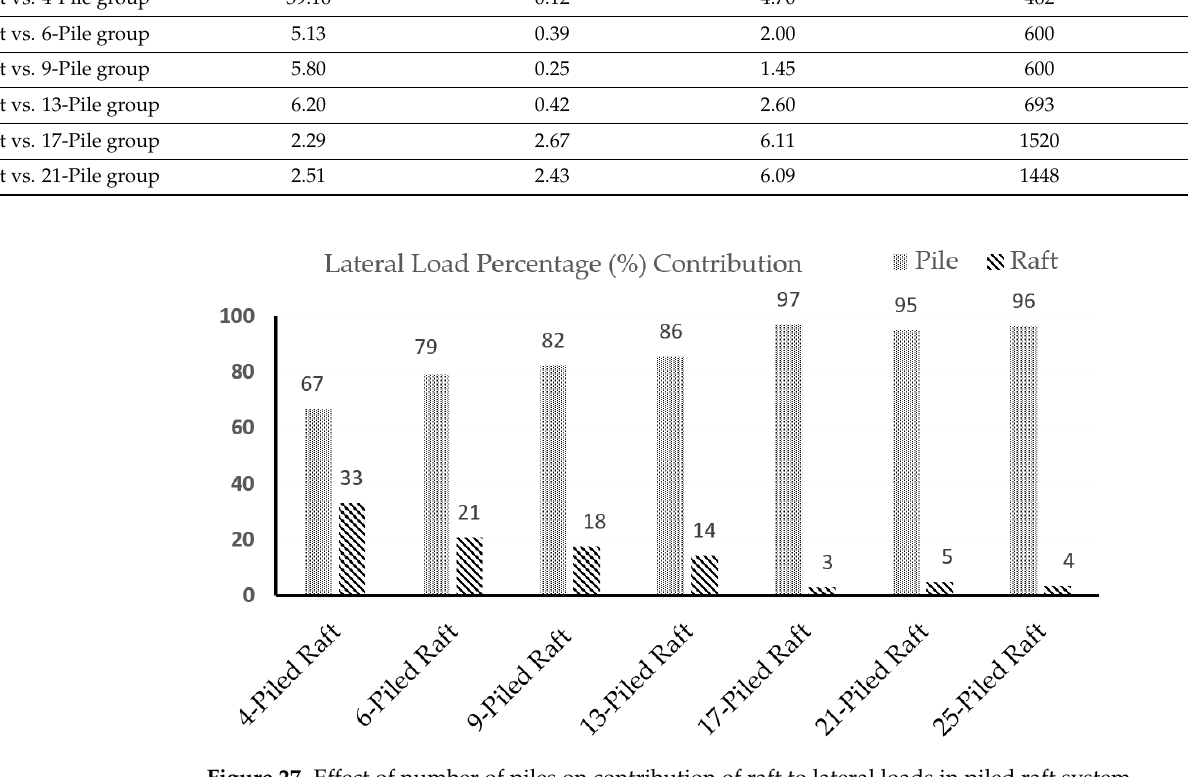
Figure 27. Effect of number of piles on contribution of raft to lateral loads in piled raft